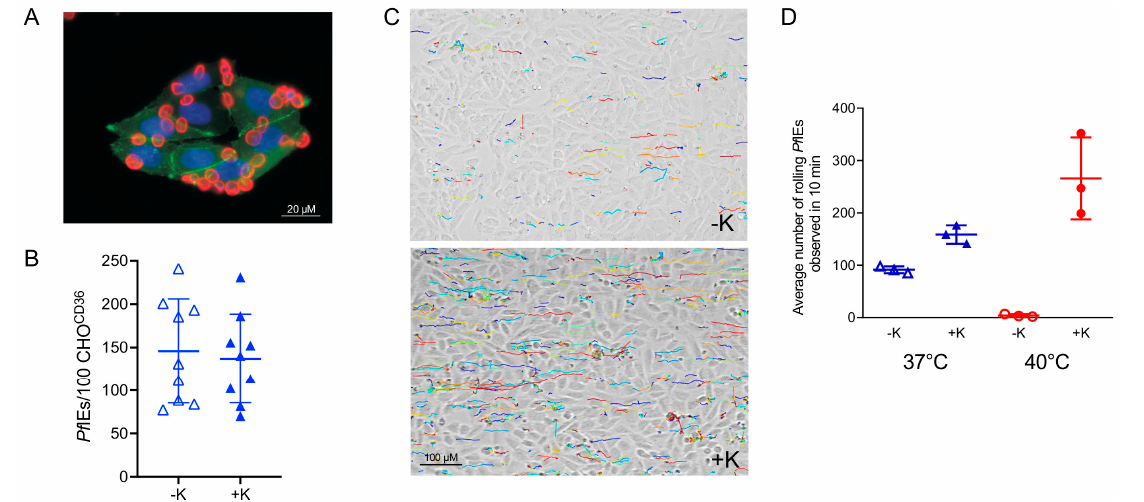
Figure 4. Cytoadhesion of knobby and knobless Pf IEs to transgenic CHO cells presenting CD36 on the cell surface (CHO CD36 ) under static and flow conditions and at different temperatures. ( A ) Adhesion of Pf IEs (red; anti-glycophorin A) to CHO CD36 cells (blue: nucleus (DAPI), green: cell surface (CD36-GFP fusion protein) under static binding conditions. ( B ) Cytoadhesion of knobbless ( − K) and knobby (+K) Pf IEs to CHO CD36 cells. ( C ) Trajectories showing the rolling binding behavior of knobless ( − K) and knobby (+K) Pf IEs to CHO CD36 cells. ( D ) Average number of knobless ( − K) and knobby (+K) Pf IEs adhering to CHO CD36 cells at 37 °C (blue) and 40 °C (red) at a shear stress of 0.9 dyn/cm 2 [127].